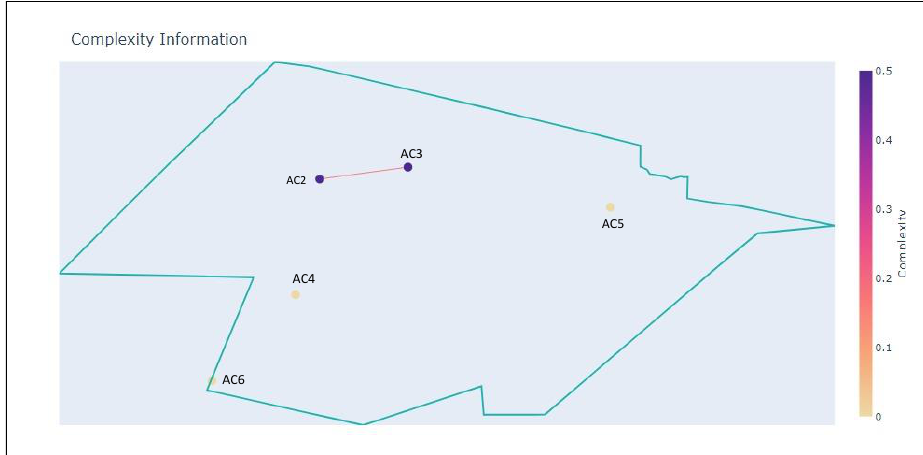
Figure 13. Initial state of the sector at t 0 without AC1.